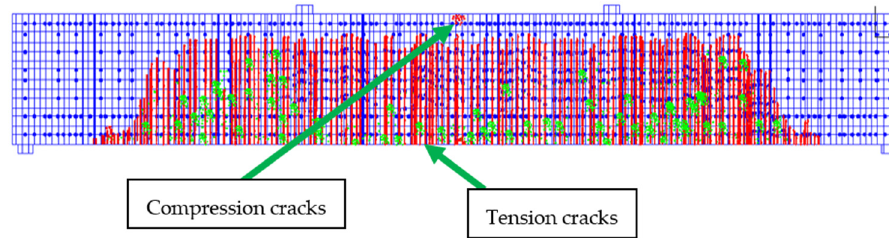
Figure 8. Cracks in sample S 0 at failure.